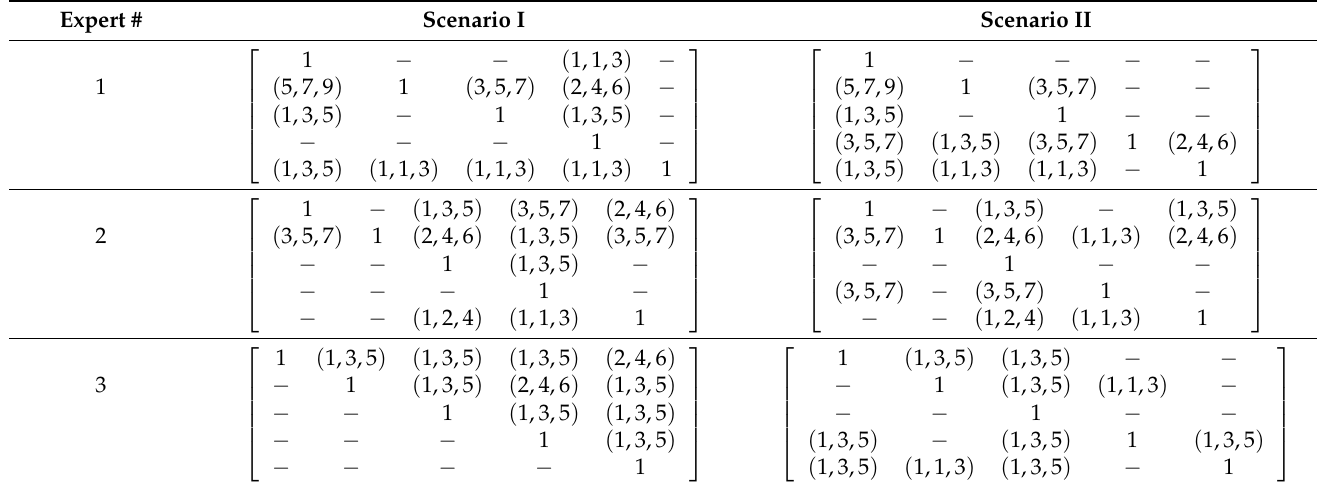
Table 2. Summary of pairwise comparison results in the two scenarios.